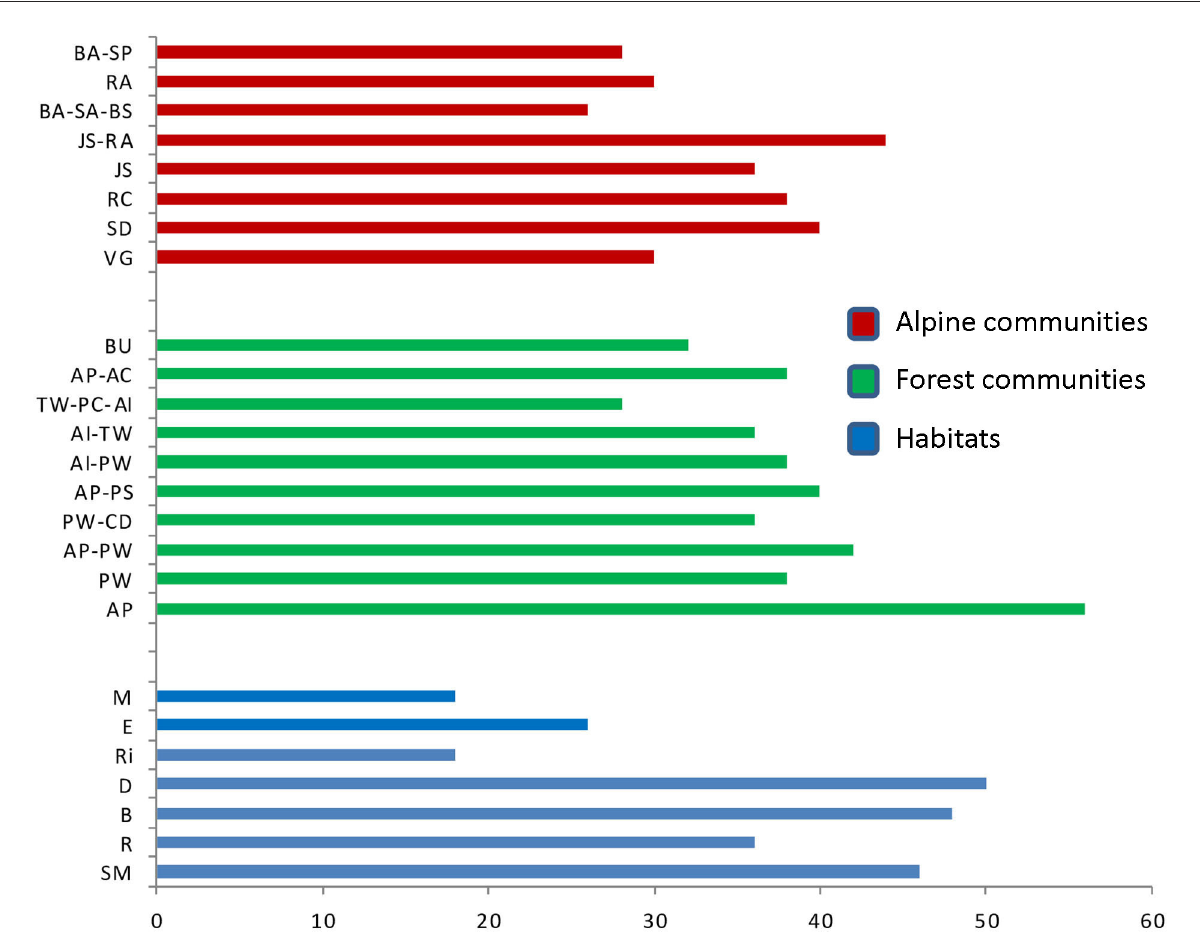
FIGURE10 CPI of delineated alpine and forest communities and habitats; BA-SP, Bistorta affinis - Swertia petiolata community; RA, Rhododendron anthopogon community; BA-SA-BS, Bistorta affinis - Saussurea acktinsonii - Bergenia stracheyi community; Juniperus squamata - Rhododendron anthopogon community; Juniperus squamata community; Rhododendron campanulatum community; Salix denticulata community; Viburnum grandiflorum community; AP, Abies pindrow community; PW, Pinus wallichiana community; AP-PW, Abies pindrow - Pinus wallichiana community; PW-CD, Pinus wallichiana - Cedrus deodara community; AP-PS, Abies pindrow - Picea smithiana community; AI-PW, Aesculus indica - Pinus wallichiana community; AI-TW, Aesculus indica - Taxus wallichiana community; TW-PC-AI, Taxus wallichiana - Prunus cornuta - Aesculus indica community; AP-AC, Abies pindrow - Acer cesium community; BU, Betula utilis community; M, Moist; E, Exposed; Ri, Riverine; D, Dry; B, Bouldary; R, Rocky; SM, Shady